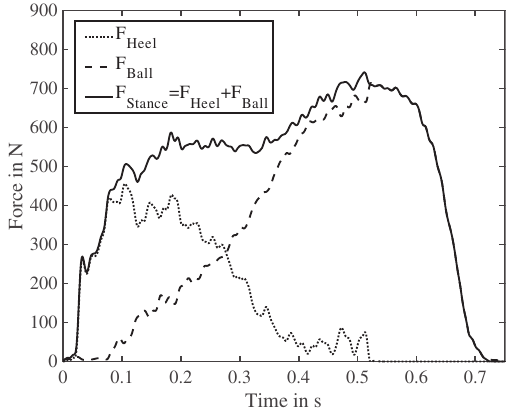
Figure 2. Example of measured stance force for barefoot walking.